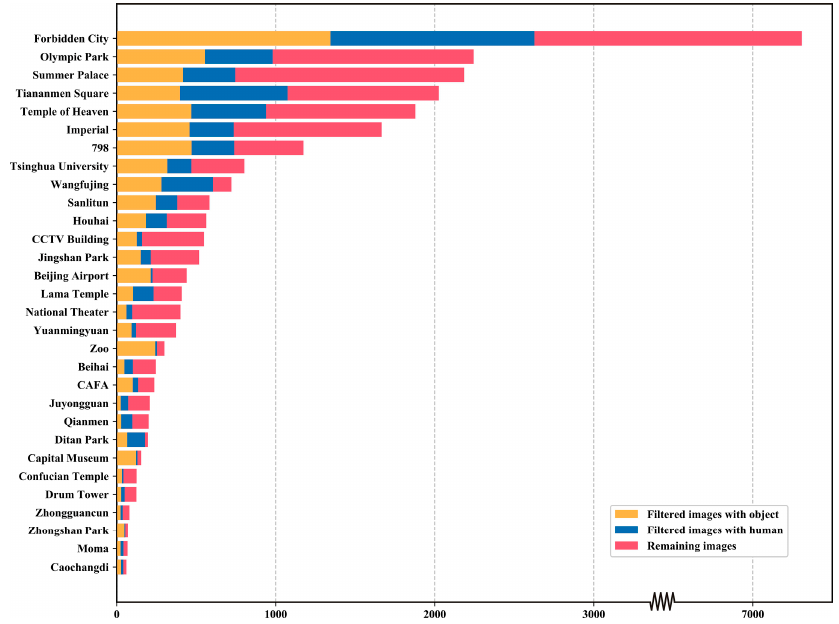
ISPRS Int. J. Geo-Inf. 2020 , 9 , 81 Figure 10. The number of filtered images and the remaining images of each tourist attraction.